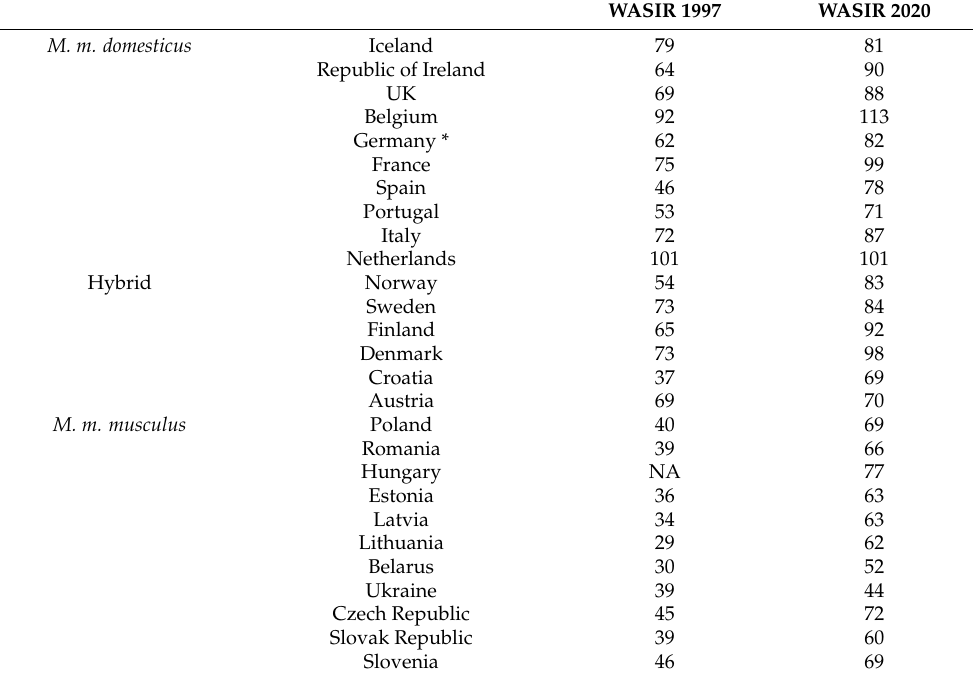
Table 1. Change in breast cancer incidence rate from 1997 to 2020 in Europe sorted by mouse range.